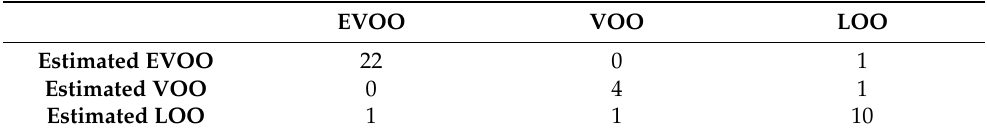
Table 4. Results of the KNN test in the case of three quality grade classes (EVOO, VOO and LOO) and the HAS reagent. EVOO VOO LOO Estimated EVOO 22 0 1 Estimated VOO 0 4 1 Estimated LOO 1 1 10